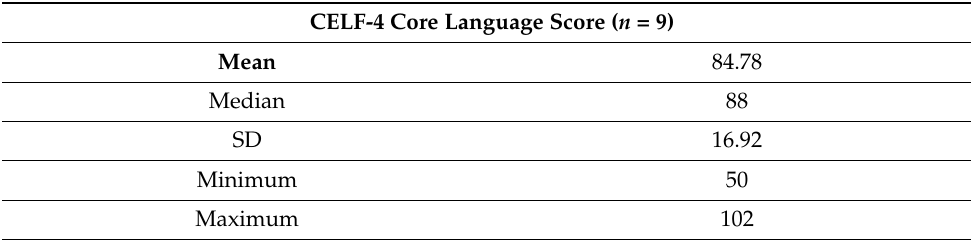
Table 2. Group CELF-4 Core Language Score (mean, median, SD, range).